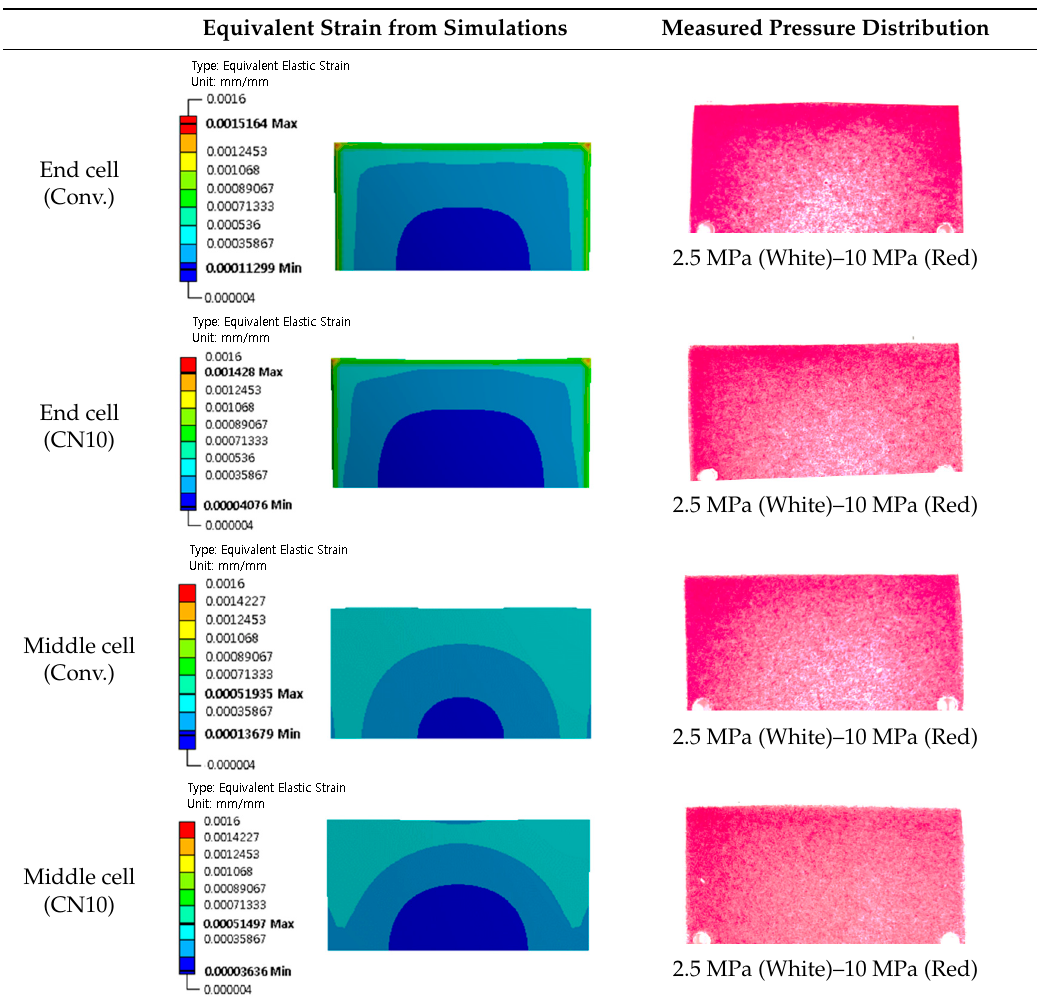
Table 6. Comparison of the simulated equivalent-strain distribution with the experimental pressure distribution, using the square end plates of the dummy-cell stack.